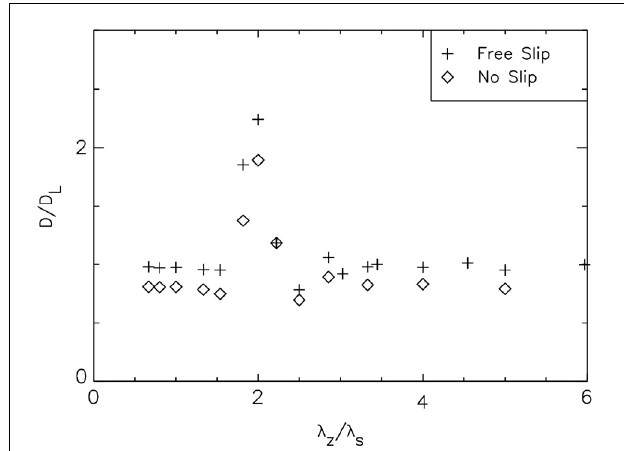
FIGURE 10 | Drag normalized by its reference value for constant l 0 as a function of λ z /λ s , where λ s is the wavelength of the vertical oscillation of the Scorer parameter. See legend for details. Reproduced from Figure 9 of Wells and Vosper [99]. © Crown Copyright 2010. Published by John Wiley & Sons,